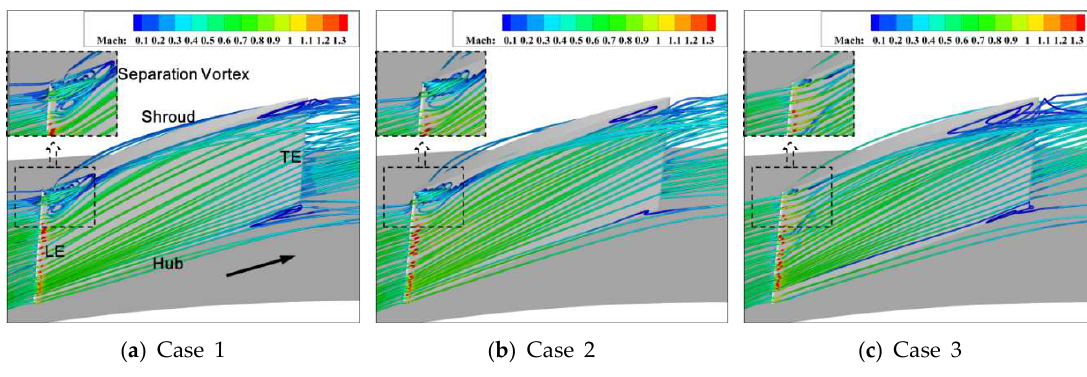
Figure 13. The total pressure loss contour at the 95% span of the diffuser.